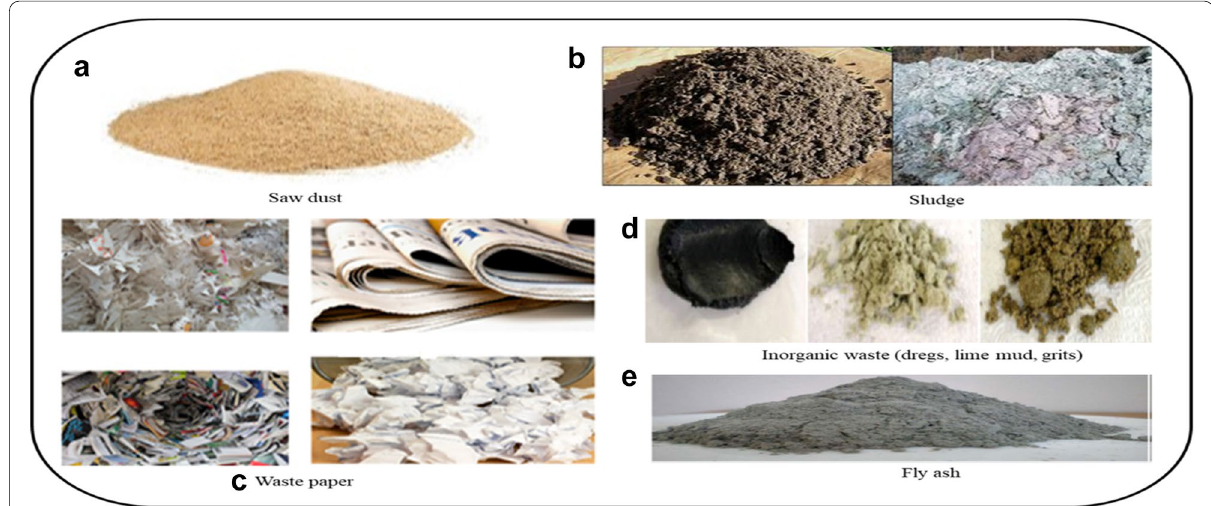
Fig. 6 Major wastes generated from pulp and paper mills: a sawdust; b sludge; c waste paper; d inorganic wastes (dregs, lime mud, grits); e Fly